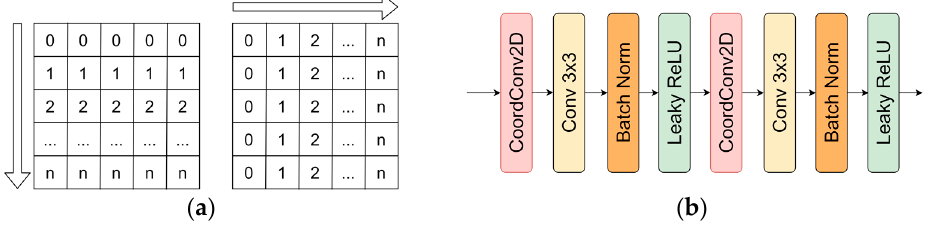
Figure 6. CoordConv2D representation: ( a ) 2 feature maps along x - and y -axis, indicating the position of the pixel at each axis; ( b ) CoordConv2D implementation before convolutional operation (adds 2 features maps—y-axis rows and x-axis columns indices).